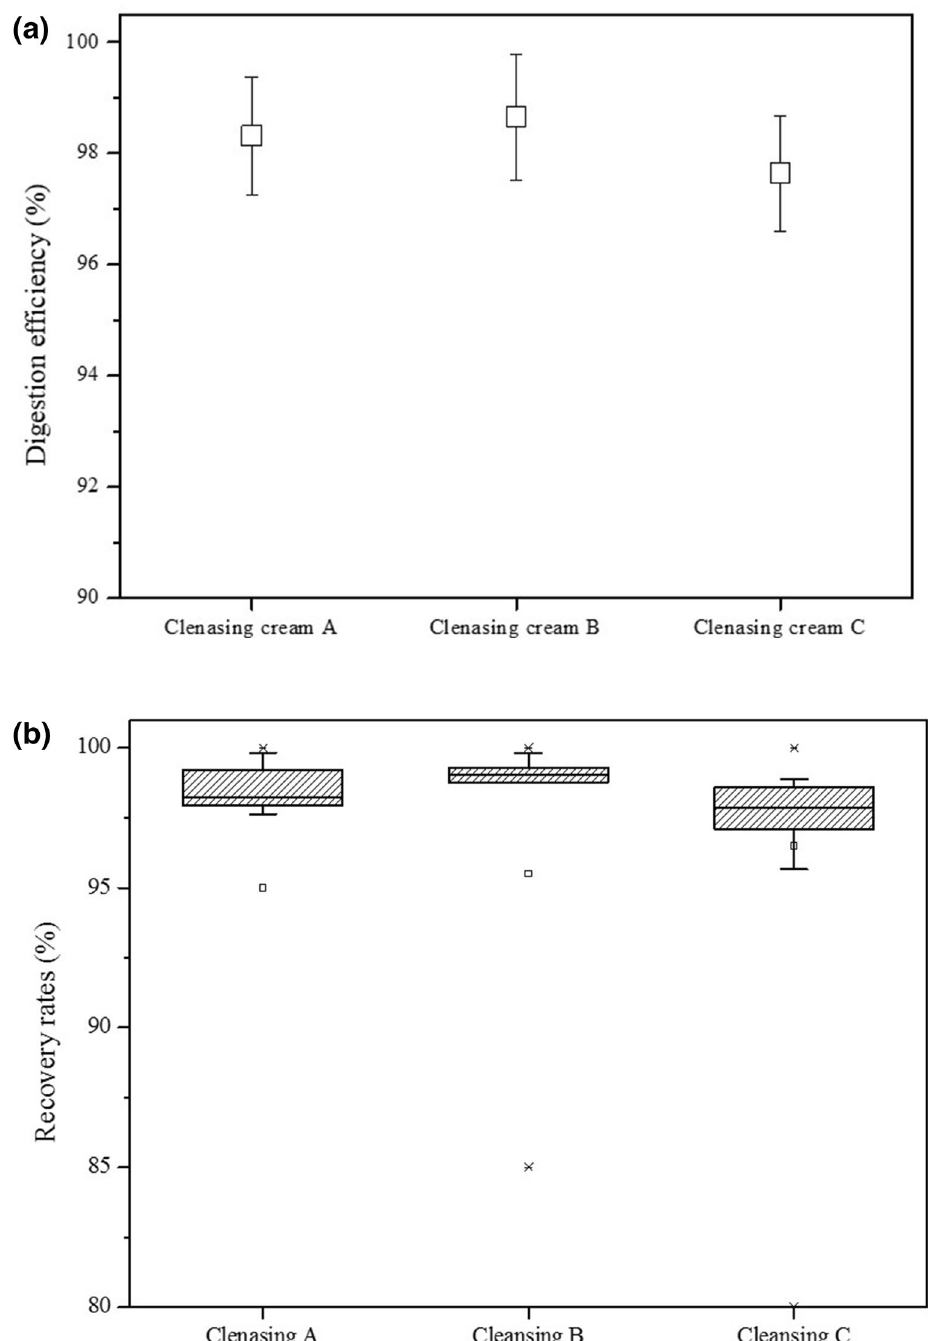
Figure 2. ( a ) Digestion efficiency and ( b ) recovery rates for KOH